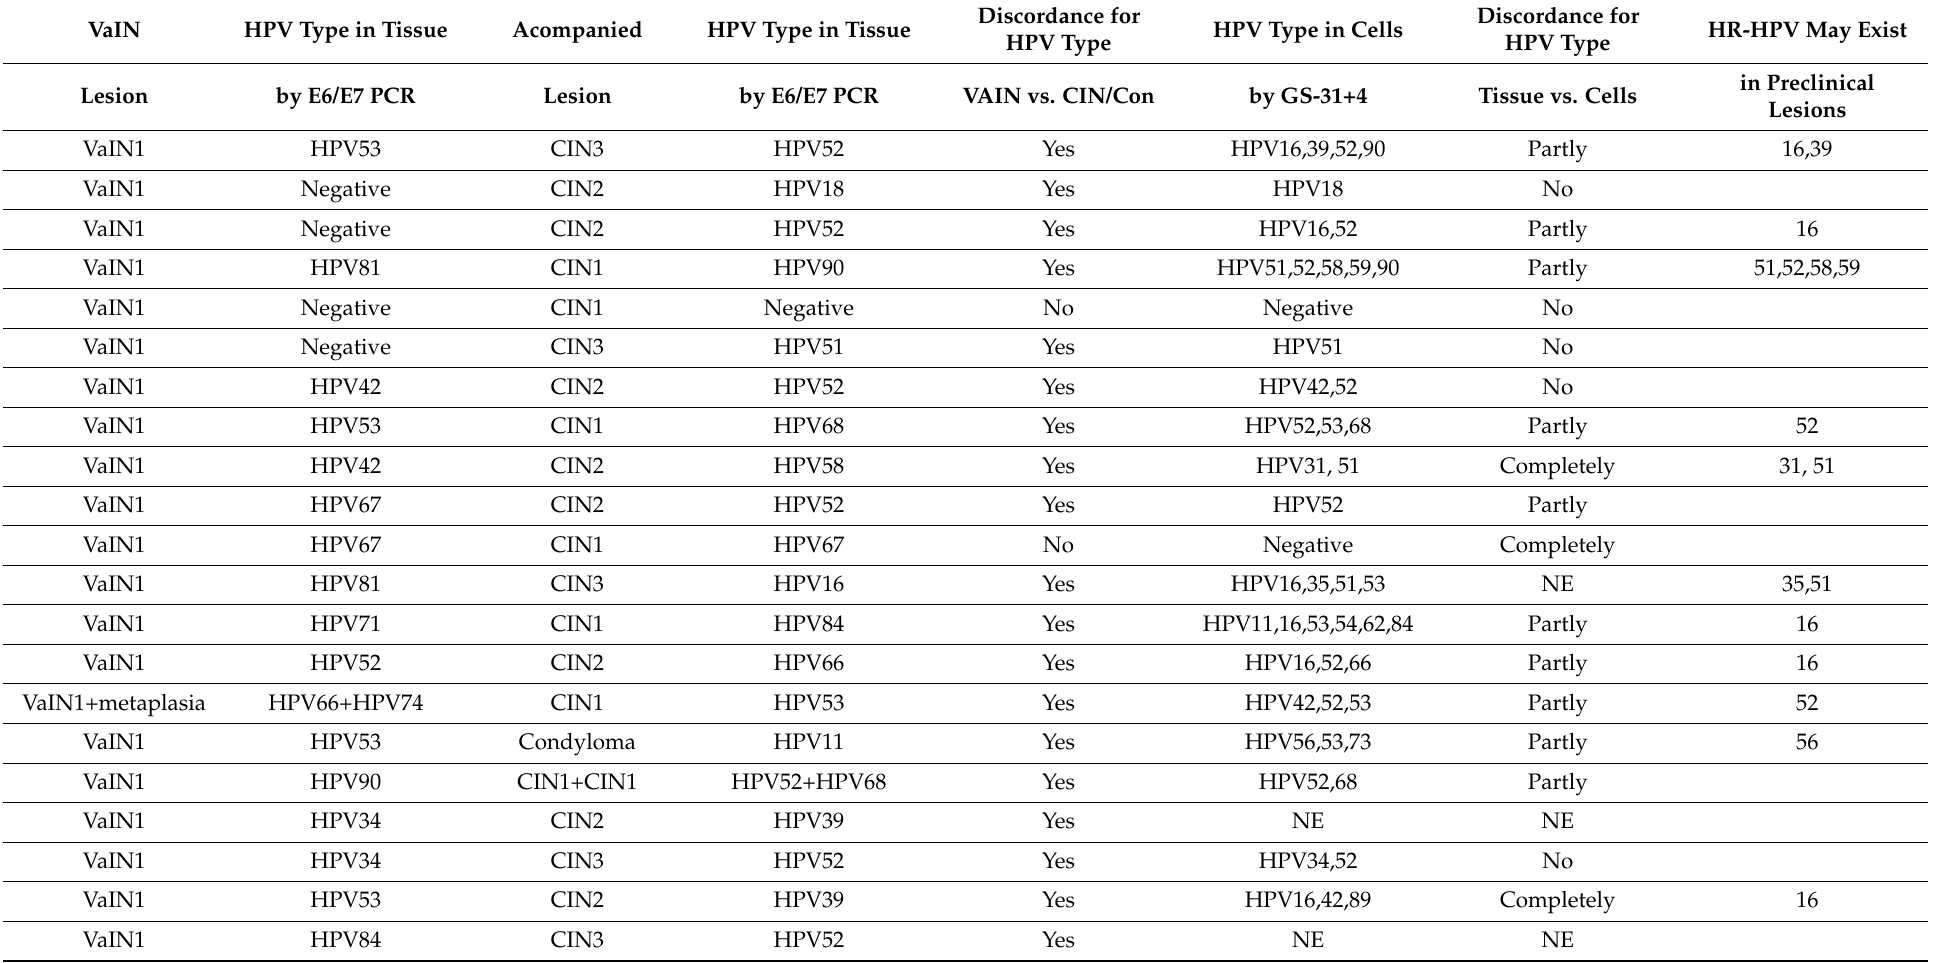
Table 4. Compariosn of HPV type results determined by tissue or scraped cell-samples in cases with multiple